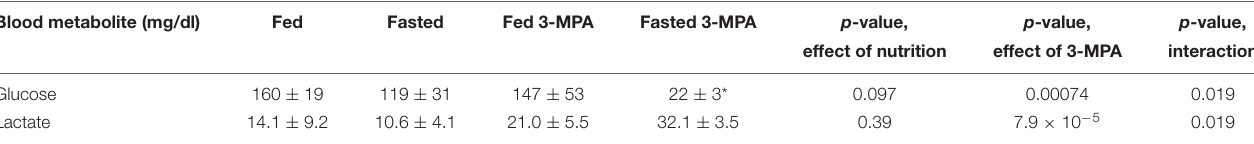
effect of nutrition effect of 3-MPA interaction